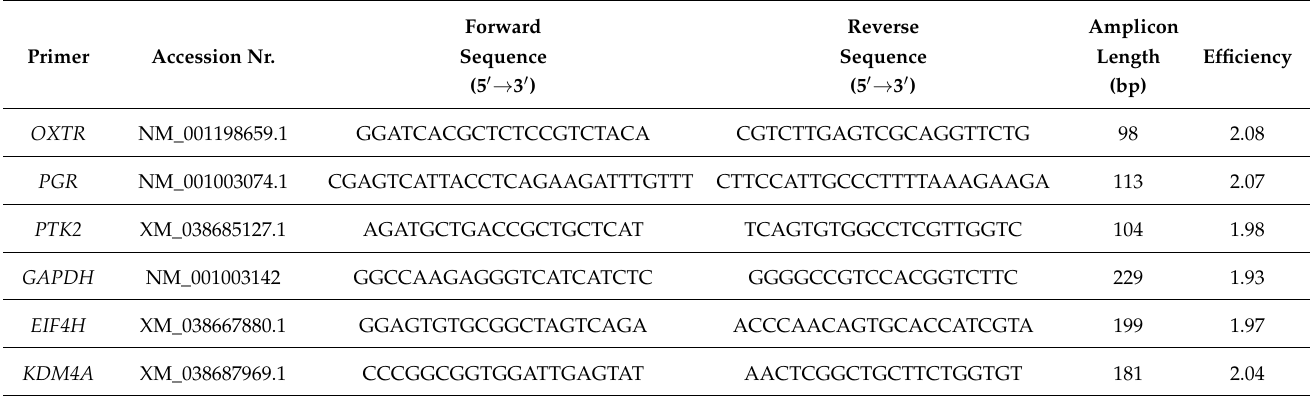
Table 1. Sequence of primers for RT-PCR and RT-qPCR, amplicon length, efficiency, and accession